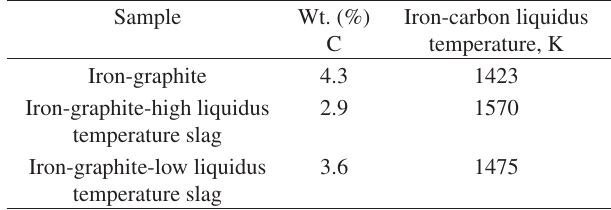
Table 3. Iron carbon content after the carburizing experiments.